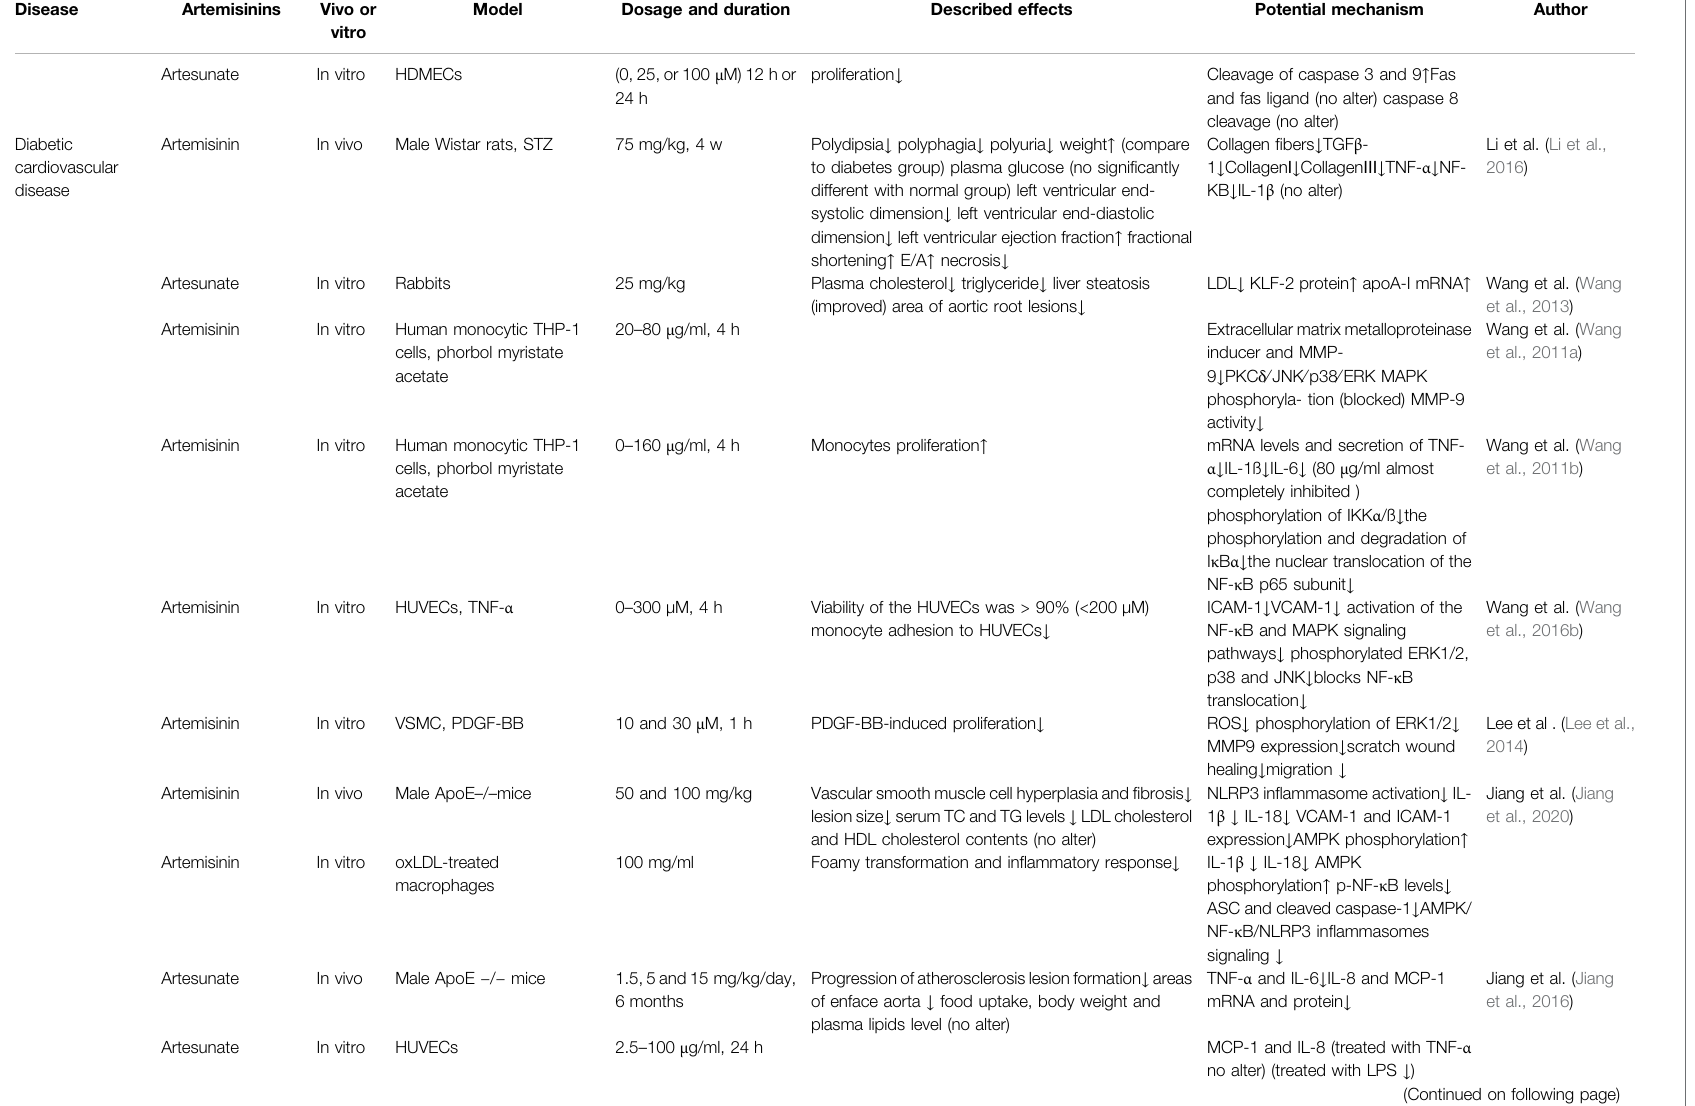
TABLE 2 | ( Continued ) Effects of Artemisinins on T2DM Associated